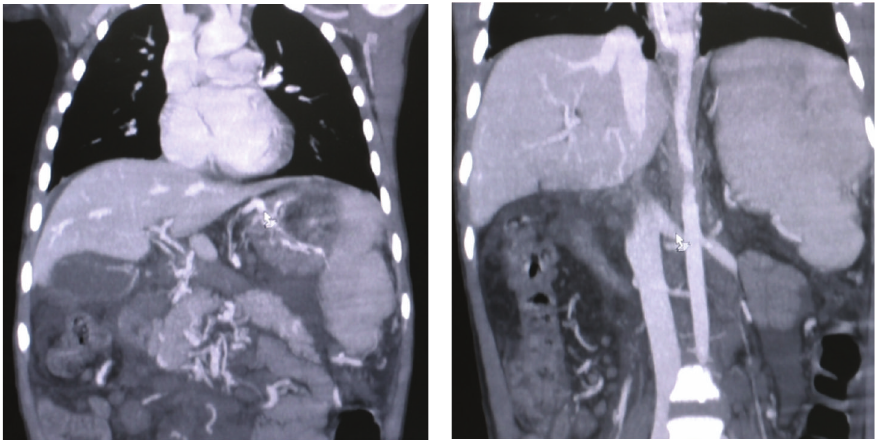
Figure 4: Dilation of coronary and left renal veins.